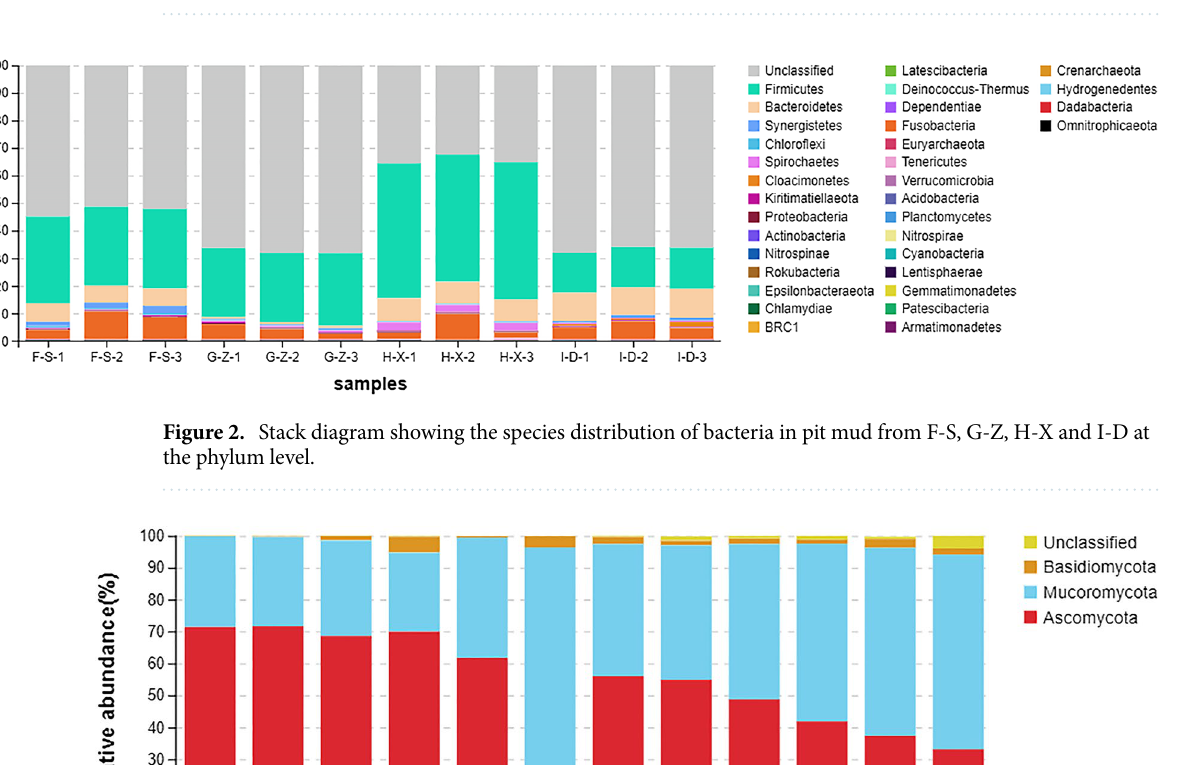
Figure 1. Venn diagram showing the numbers of operational taxonomic units found in pit mud from F-S, G-Z, H-X and I-D.